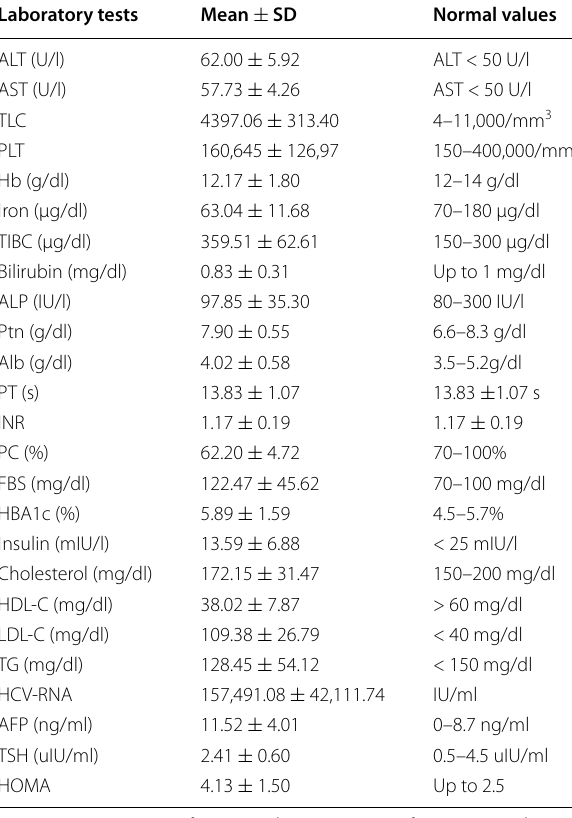
Table 2 Laboratory results Table 3 Relation between metabolic syndrome and grade of steatosis, activity, and fibrosis stage according to SAF